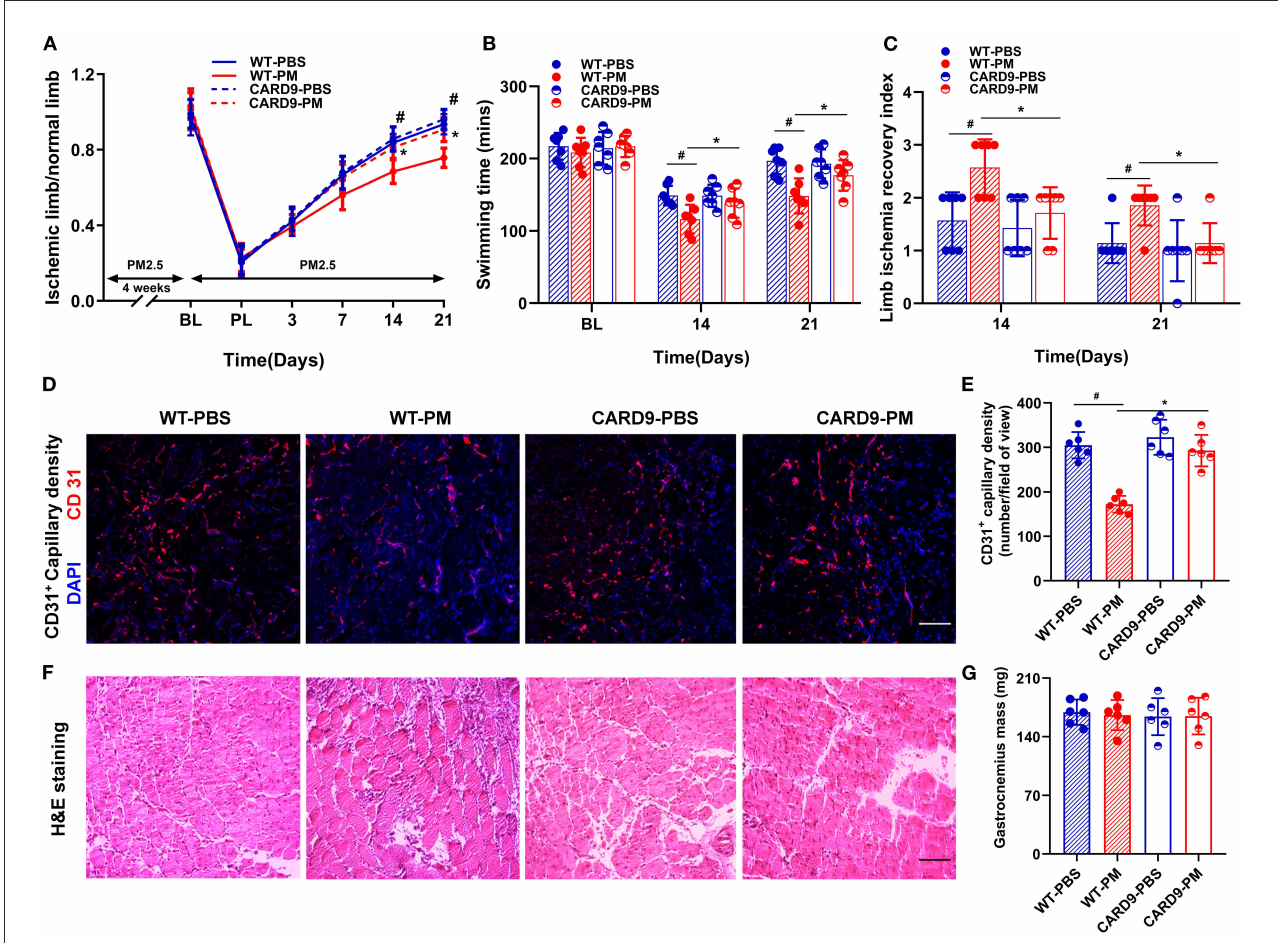
FIGURE5 CARD9 deficiency effectively prevented PM-induced impairment in the recovery of blood flow and mechanical function of ischemic limbs, preserved capillary density and attenuated inflammatory infiltration in ischemic limbs. To determine the effect of CARD9 on the recovery of ischemic limb in mice with PM exposure, we performed animal experiment with age-matched CARD9 deficient (CARD9 − / − ) mice. As shown in (A) , CARD9 knockout effectively prevented the PM-induced reduction of blood flow recovery (* p < 0.01 for WT-PM vs. CARD9-PM; # p < 0.01 for WT-PBS vs. WT-PM). In the meanwhile, CARD9 knockout partially, but significantly reversed the reduction of mechanical function in ischemic limbs in mice with PM exposure at days 14 and 21 [* p < 0.05, # p < 0.05; (B, C) ]. Interestingly, there was no significant difference in the recovery of blood flow and mechanical function between CARD9 and WT mice with PBS treatment. Consistent with the recovery of blood flow and mechanical function, ex vivo histological analysis showed that CARD9 deficiency effectively prevented PM-induced decrease of CD31 + capillary density and attenuated inflammatory cell infiltration in ischemic limbs [* p